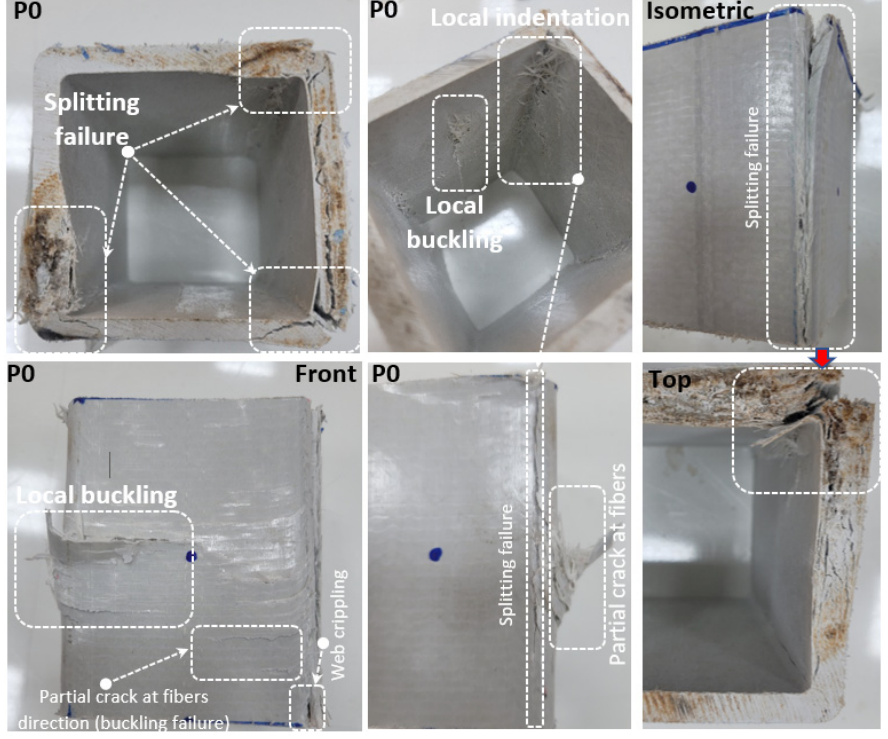
Figure 5. Damage analyses of P0.